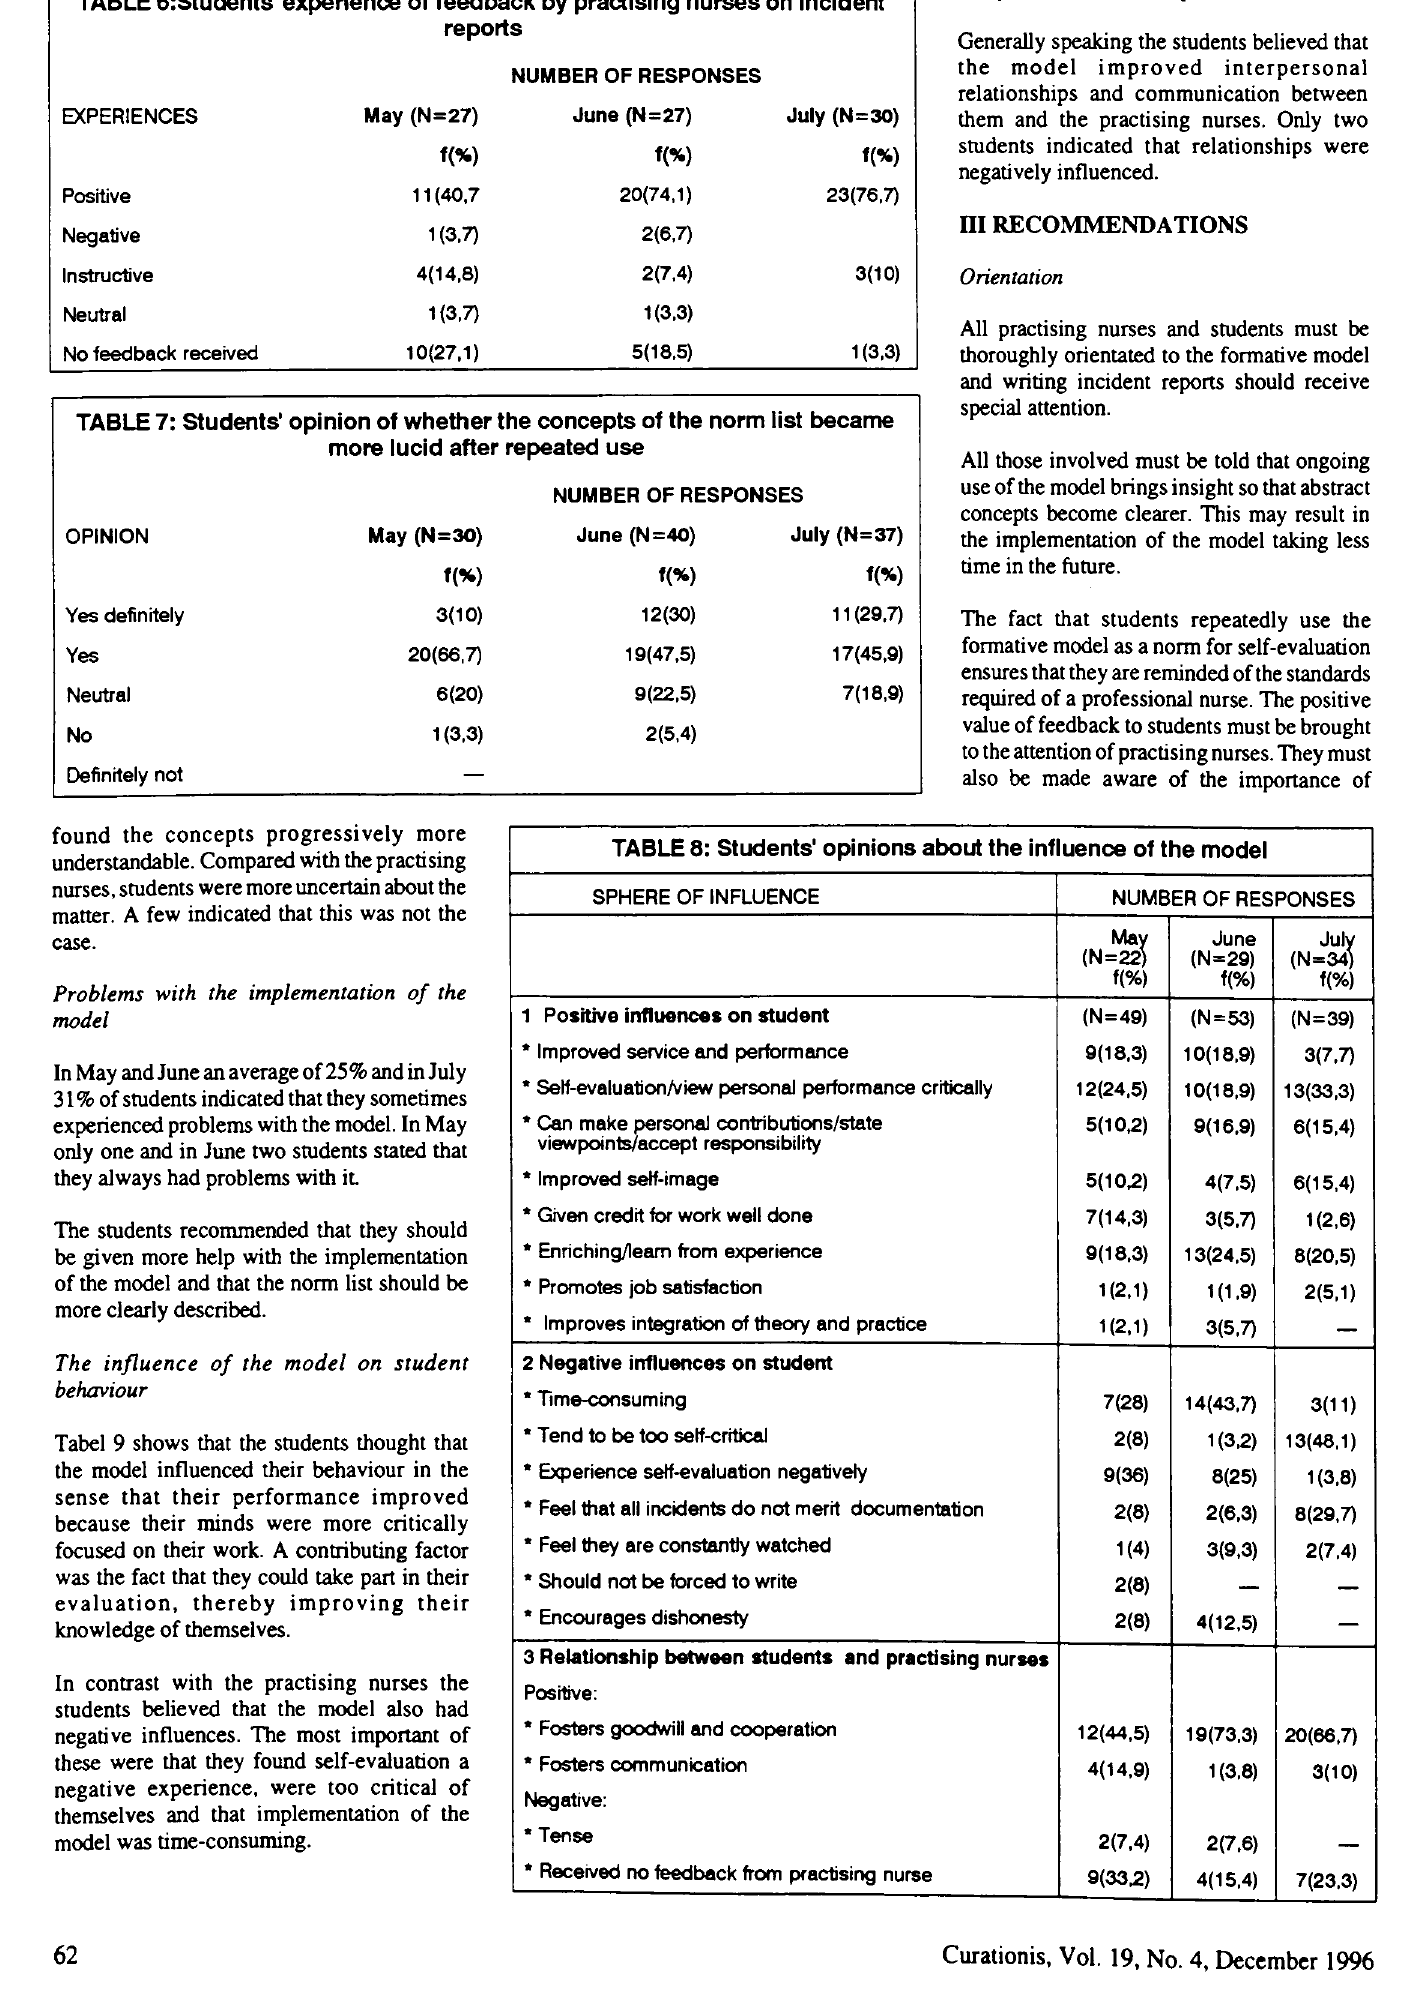
TABLE 6:Students' experience of feedback by practising nurses on incident reports